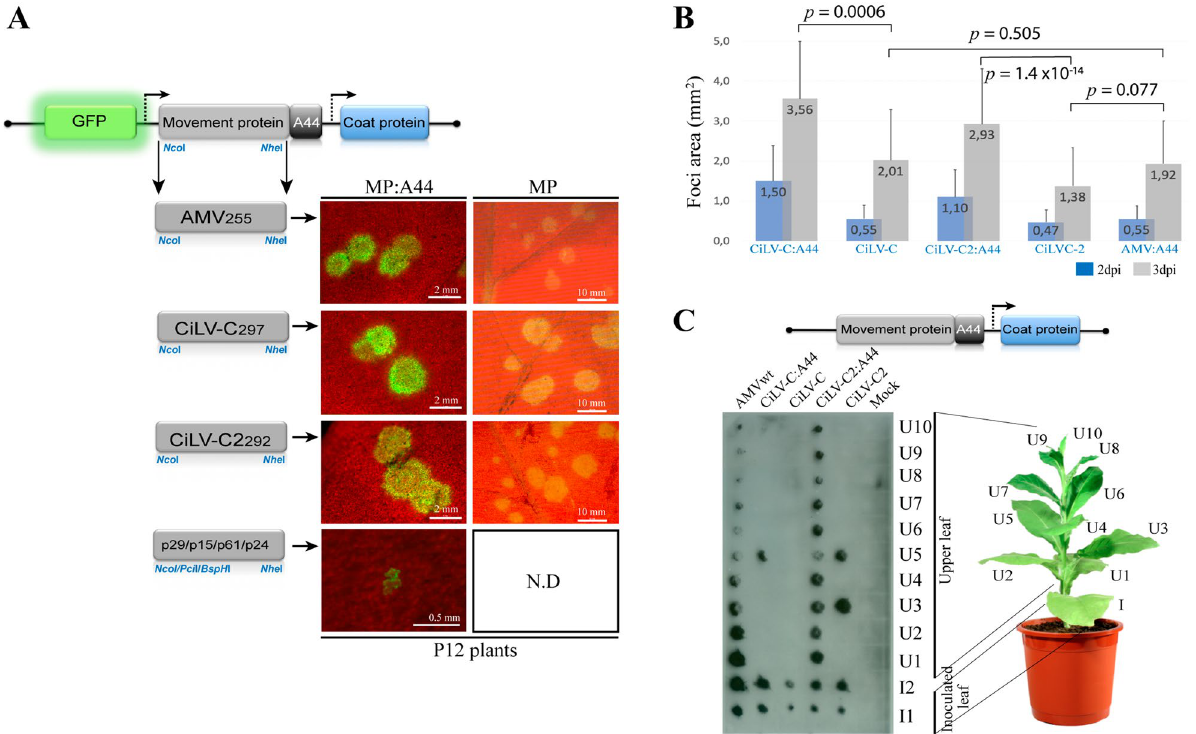
Figure 1. The cileviruses MPs complement the cell-to-cell and systemic movement of the AMV infectious clone. Analysis of the cell-to-cell and systemic transport of the hybrid AMV RNA 3 in which its MP gene was exchanged with the corresponding genes (MPs) of CiLV-C and CiLV-C2 and the genes p29, p15, p61 and p24 of CiLV-C. ( A ) Infection foci observed in P12 plants inoculated with RNA 3 transcripts from pGFP/ A255/CP derivatives carrying the AMV MP lacking the C-terminal 44 residues (A44) (MP), the AMV MP wild type (MP:A44), and the aforementioned heterologous MPs alone (right panels; MP) or fused to A44 (left panels; MP:A44). The schematic representation shows the GFP/A255/CP AMV RNA 3 29 , in which the open reading frames, represented by large boxes, correspond to the green fluorescent protein (GFP), the movement protein (MP) and the coat protein (CP). Short box corresponds the C-terminal 44 amino acids of the AMV MP, meanwhile arrows represent subgenomic promoters. The numbers after the viral acronym represent the total amino acids residues of the corresponding MP. The Nco I and Nhe I restriction sites used for insertions of the MPs are indicated, as well as the restriction sites BspH I, Pci I and Nhe I for insertions of the other CiLV-C genes. White bars represent to 500 μm, 2 mm and 10 mm. N.D non-determined. ( B ) Histograms represent the average of the area in mm 2 of 80 independent infection foci at 2 and 3 days post-inoculation (dpi). Error bars indicate the standard deviation. Student’s t -test and significance was set at p < 0.05. The p -values obtained from comparison between pairs of groups are presented. ( C ) Tissue-printing analysis of P12 plants inoculated with the AMV RNA 3 derivatives showed in A but lacking the 5 ′ proximal GFP gene. Plants were analyzed at 14 dpi by printing the transversal section of the corresponding petiole from inoculated (I) and upper (U) leaves. Mock corresponds to non-inoculated